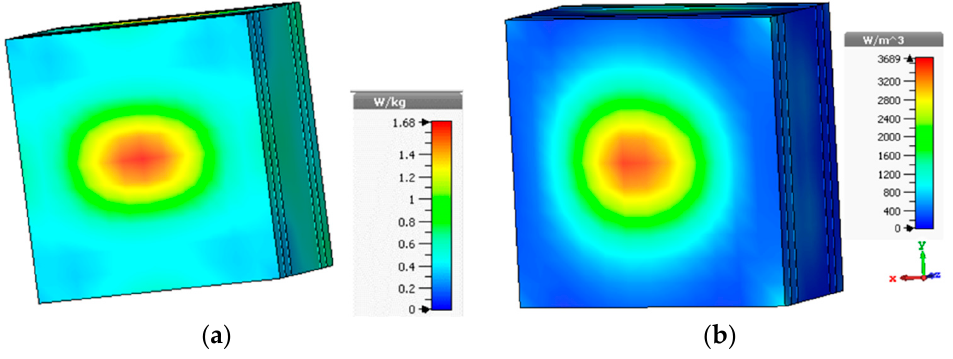
Figure 12. ( a ) Specific absorption rate (SAR) analysis at 1.64 GHz (10-g SAR); ( b ) power loss density over the phantom at 1.64 GHz.